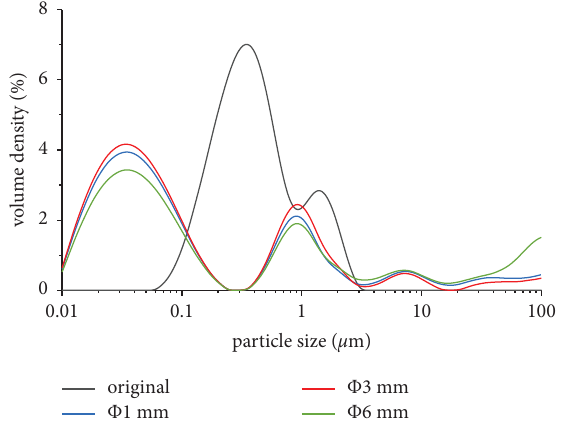
Figure 2: Particle sizes’ distribution of original dispersed orange 31 samples and after grinding with Φ 1mm, Φ 3 mm, and Φ 6 mm media.